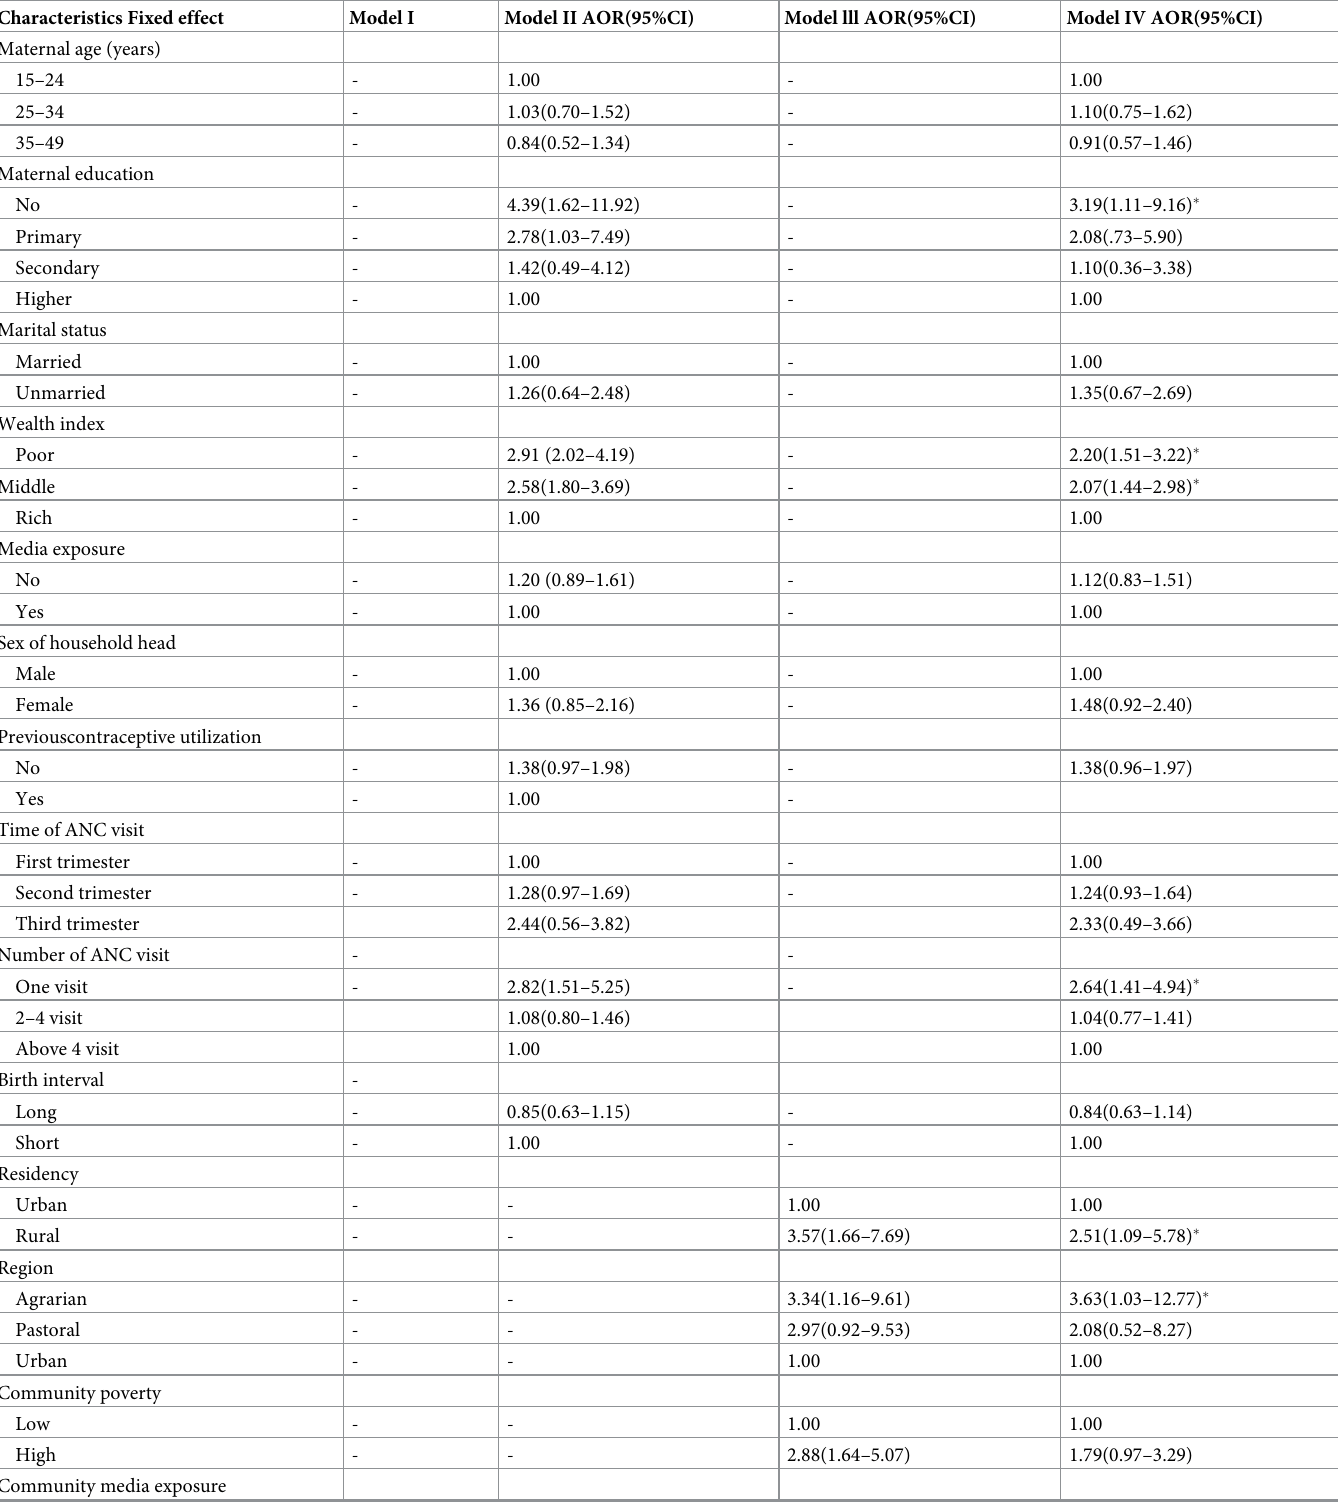
Table 4. Multilevel logistic regression analysis of individual and community-level factors associated with home delivery after ANC visit in Ethiopia, MEDHS